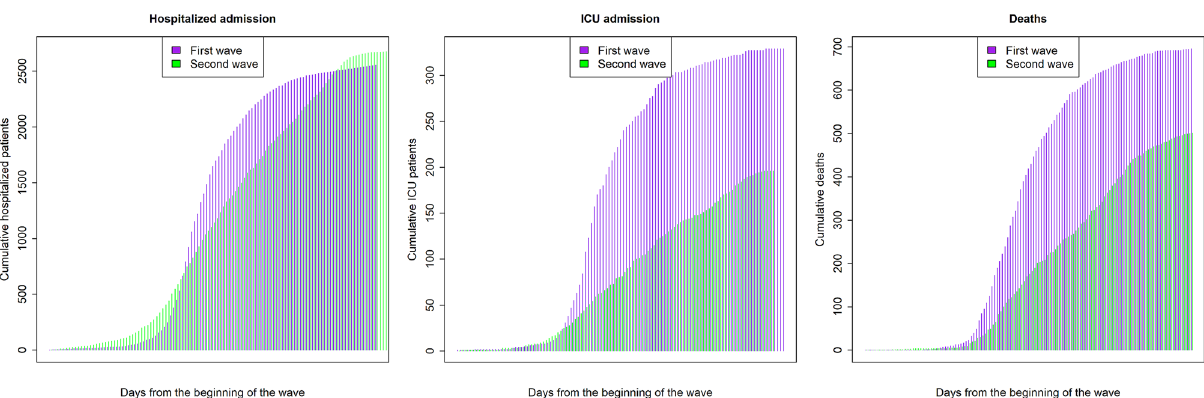
Figure 3. Comparison of cumulative cases between pandemic waves in Aragon, Spain, February-September 2020. Prevalence of SARS-CoV-2 cases confirmed by RT-PCR during the first ( purple ) and second waves ( green ) are shown for hospitalized patients ( left panel ), ICU admissions ( middle panel ), and deaths ( right panel ). ICU: intensive care